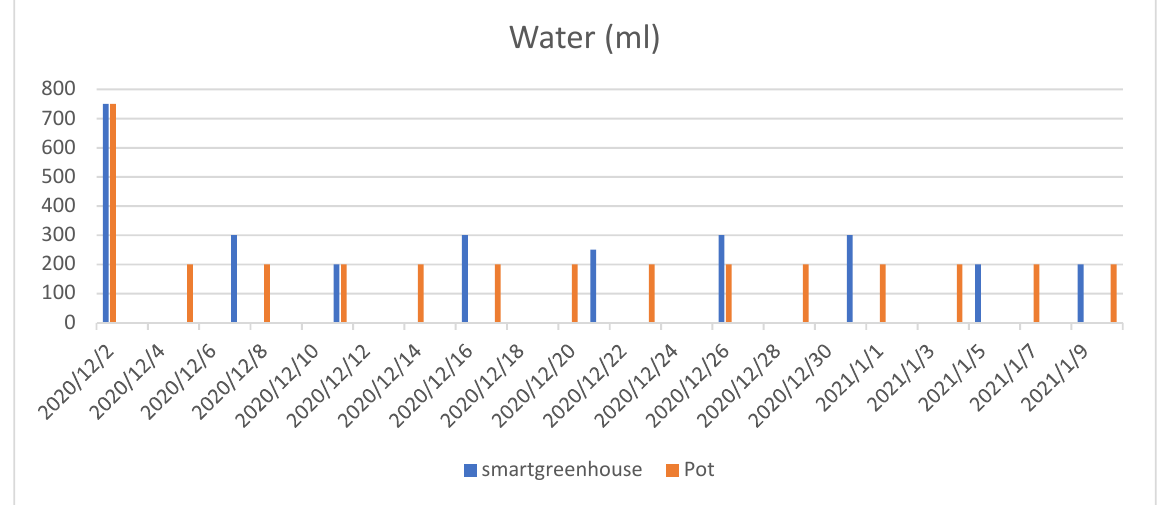
Figure 12. The amount of water the plants consumed in smart greenhouse and pot. The development of the plants in the smart greenhouse and the pot are shown in Figures 13–16.